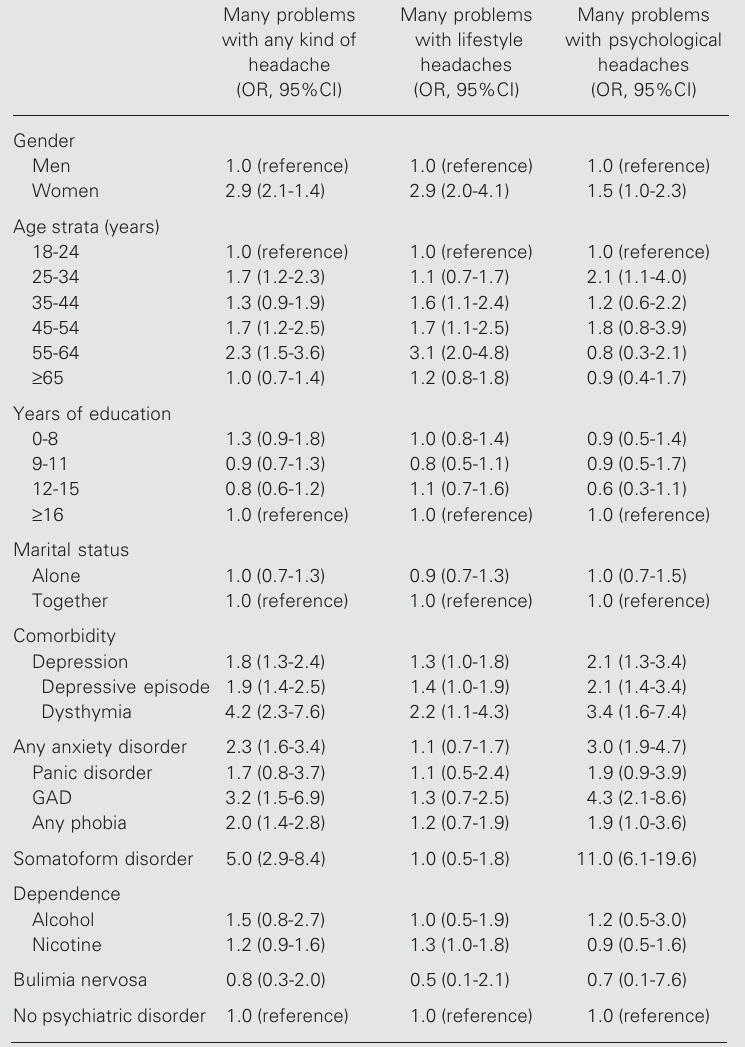
Table 2. Association between headache, sociodemographic measures and psychiat- ric